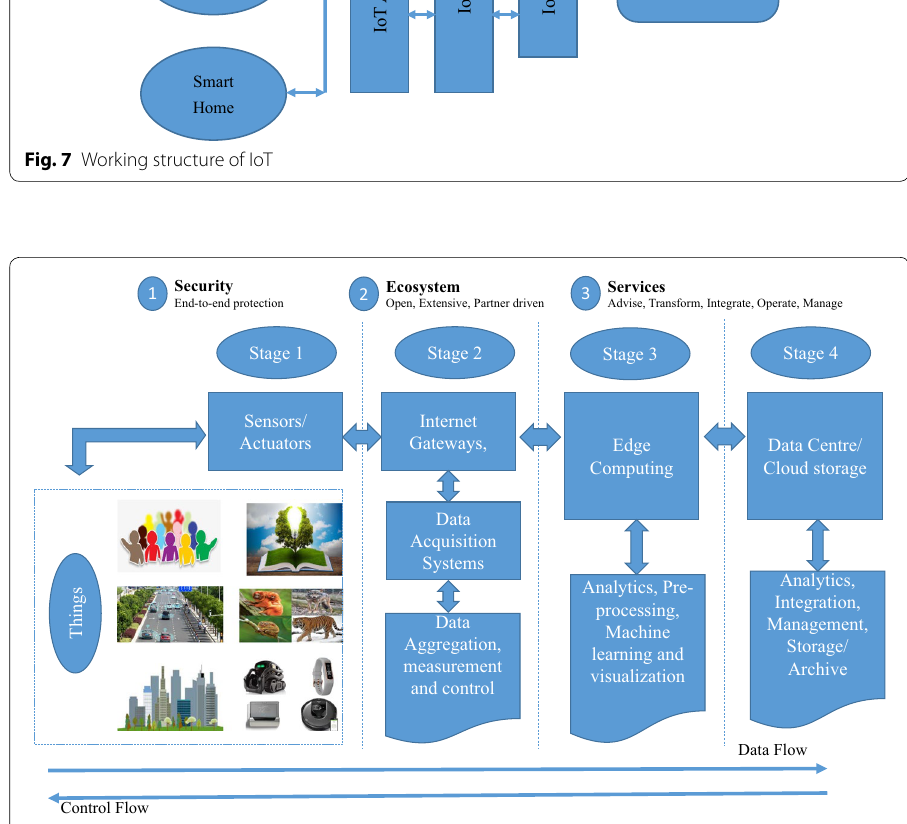
Fig. 8 Four stage IoT architecture to deal with massive